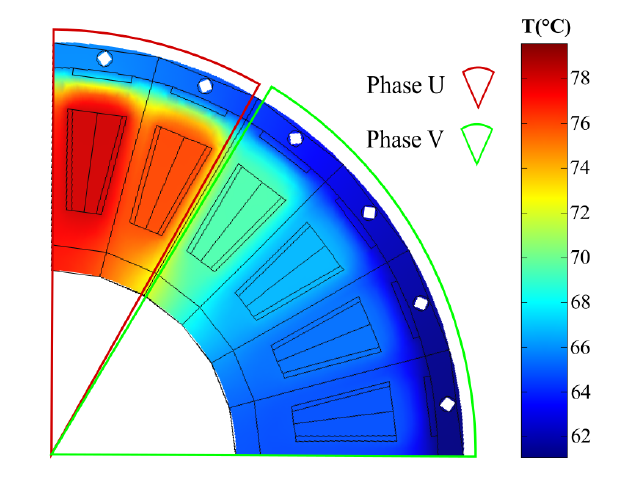
Figure 13. Steady-state temperature distribution in the stator with round enamelled copper wire without thermal end-winding interconnection, with a 24 slots, 22 or 26 poles